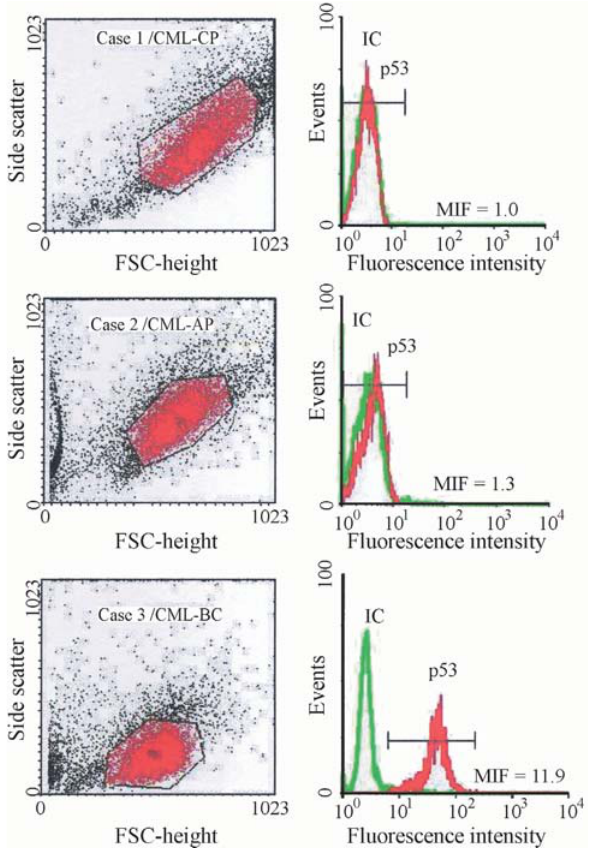
Figure 2 - Analysis of p53 expression by flow cytometry. Samples were incubated with p53 monoclonal antibodies (MoAb) labeled with FITC. In the left column, plots of the cell scattering. The FSC (forward scatter) rep- resents the size of the cells and side scatter, their internal complexity. The right column shows the p53 expression estimated as a ratio of the arithme - tic mean of the intensity of fluorescence (MIF) in cells labeled with anti p53 MoAb (red histogram) and the MIF for cells labeled with the isotypic control (IC) (green histogram). The samples were considered positive when the MIF was <